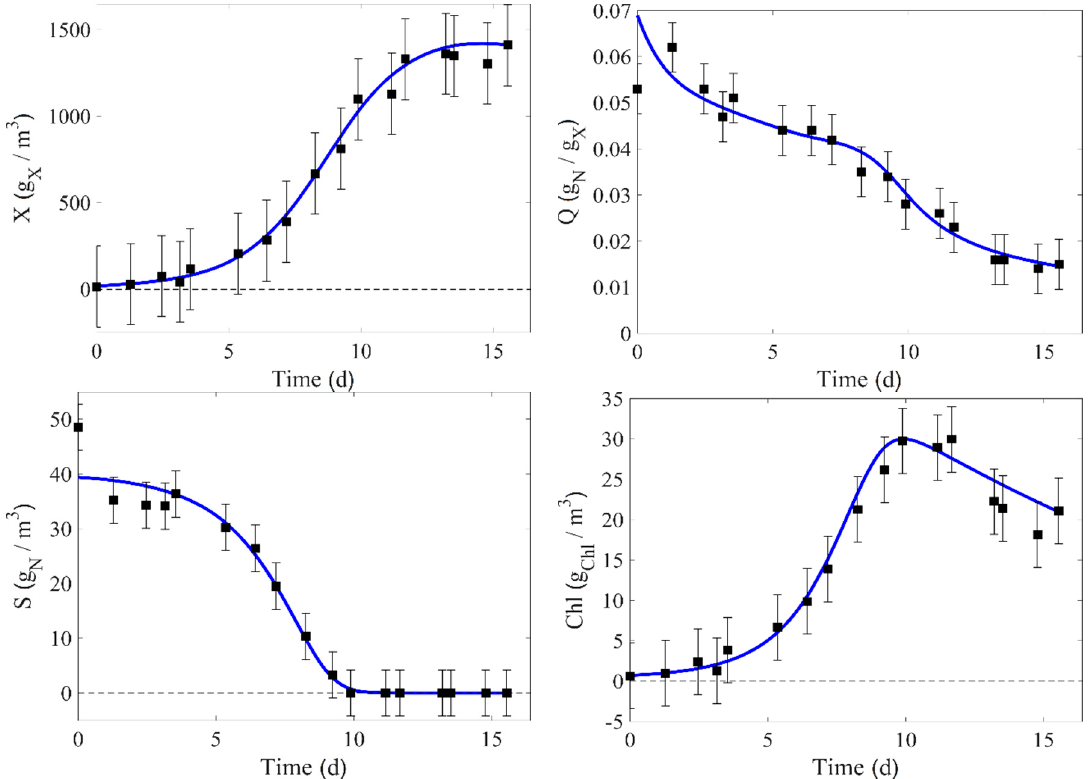
Figure 2. Experimental data (with 95% error bars) and model prediction for run 4.